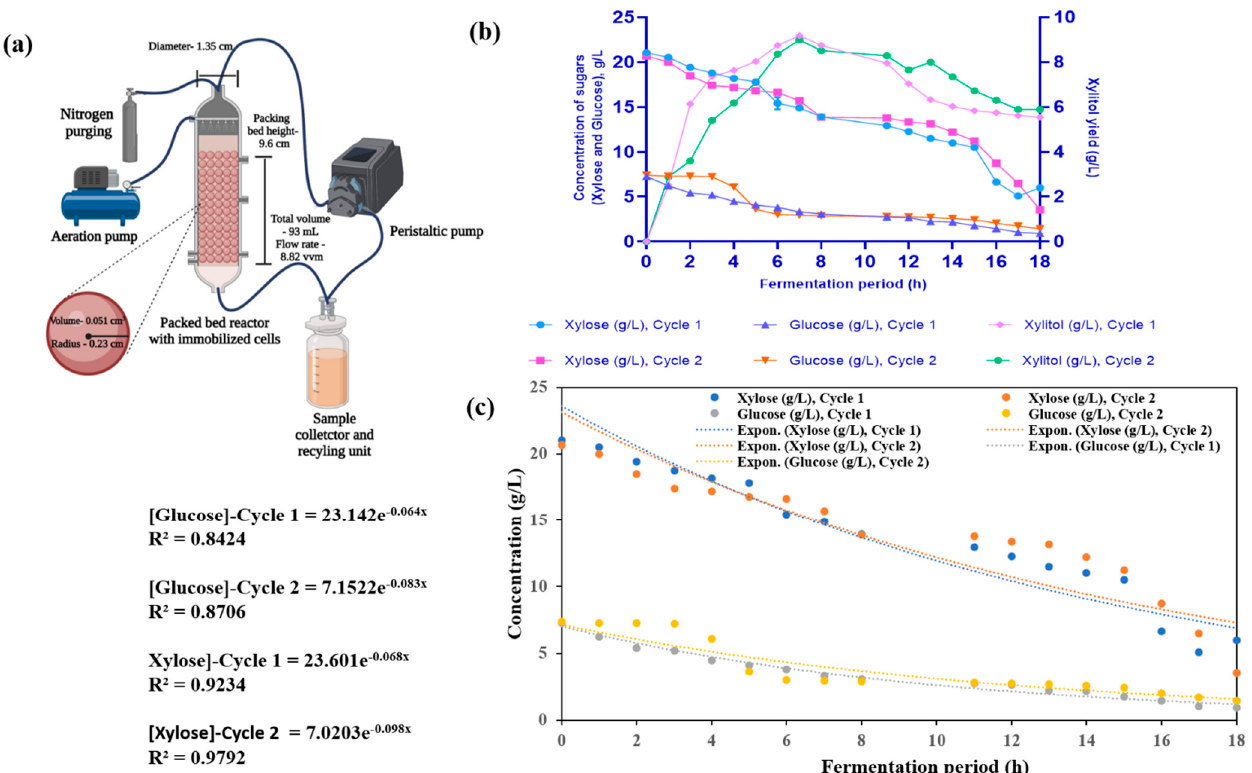
Figure 6. ( a ) Packed bed reactor (PBR) for immobilized cell-based fermentation. ( b ) Fermentation profile of hemicellulosic hydrolysate for xylitol production under microaerophilic immobilized-cell conditions. ( c) Substrate (glucose and xylose) consumption profile (based on first-order rate).